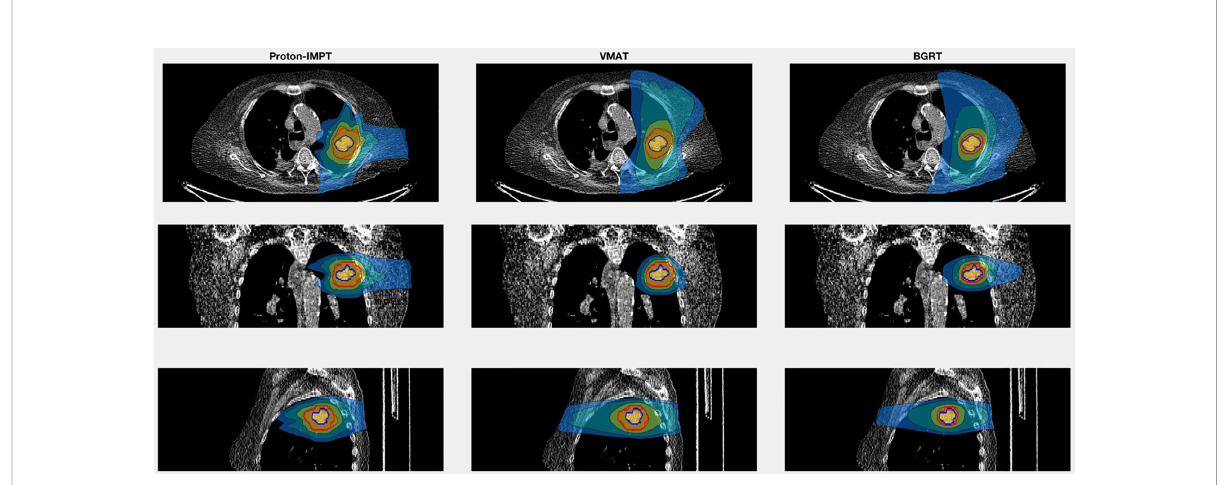
FIGURE 5 Isodose line images for case 2, involving a newly diagnosed adenocarcinoma in the upper lobe of the left lung. Isodose lines depicted are 10 Gy (blue), 20 Gy (teal), 40 Gy (green), and 50 Gy (yellow). GTV is contoured in blue. PTV displayed in red (8 mm GTV expansion for IMPT and VMAT and 3 mm for